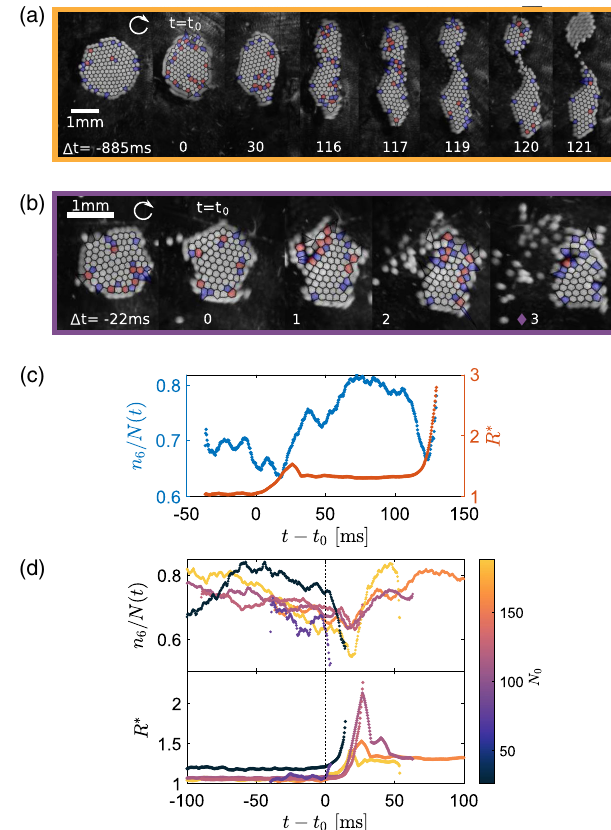
FIG. 7. Voronoi construction reveals the onset of plasticity during raft deformation. (a,b) Images in Fig. 3(a) of the main text, overlaid with the corresponding Voronoi diagram of the raft interior. Cells in the Voronoi diagram are overlaid with the corresponding number of sides of the polygon: Particles with five neighbors are shaded blue, particles with six neighbors are white, and particles with seven neighbors are red. (c) Left axis: plot of the number of particles in the raft interior with six neighbors n 6 , divided by the total number of particles in the raft N ð t Þ , as a function of time (both n 6 and N are tracked at every frame of the drop evolution), for the raft pictured in (a). Right axis: raft shape parameter R (cid:2) as a function of time. (d) Upper: n 6 =N ð t Þ as a function of time, for several different initial raft sizes N 0 . Lower: R (cid:2) as a function of time. R (cid:2) ¼ 3 and pinches off into two drops. This extreme